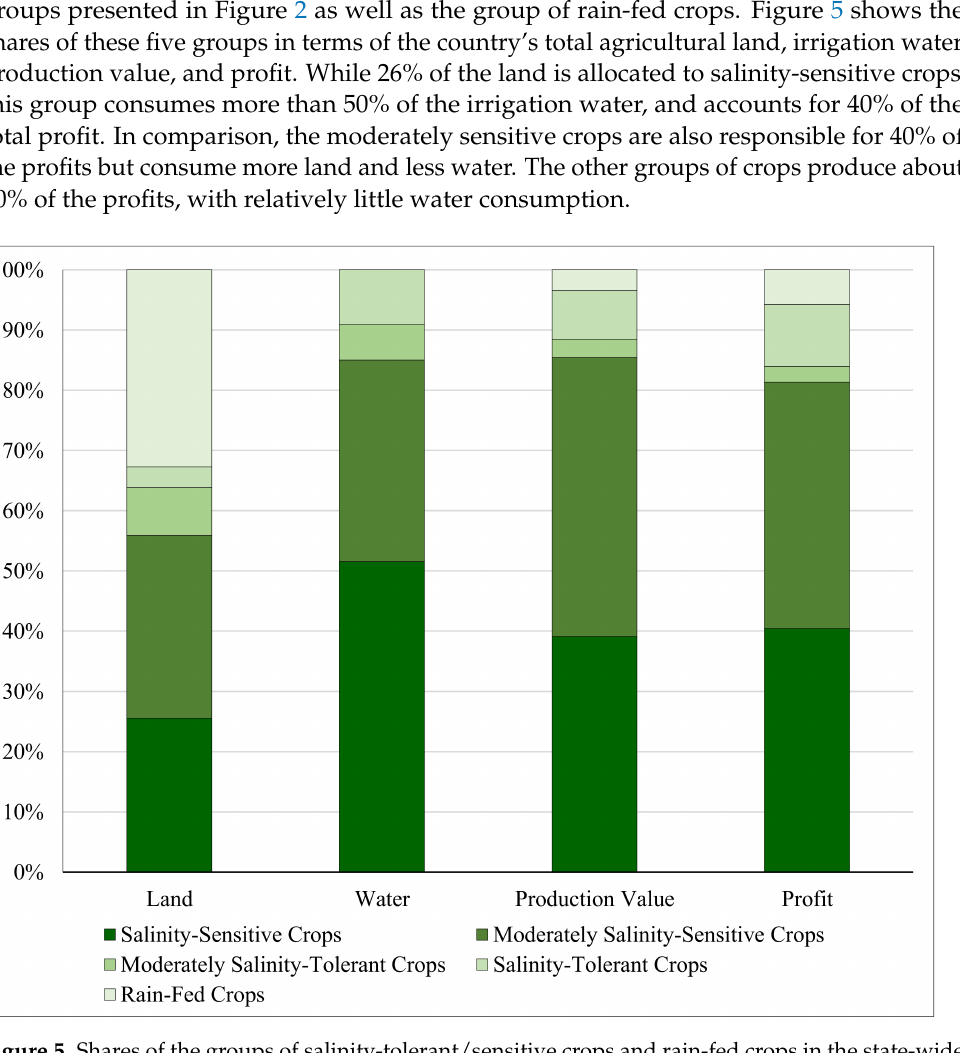
Figure 5. Shares of the groups of salinity-tolerant/sensitive crops and rain-fed crops in the state-wide total agricultural land, irrigation water use, production value, and profit at the calibration